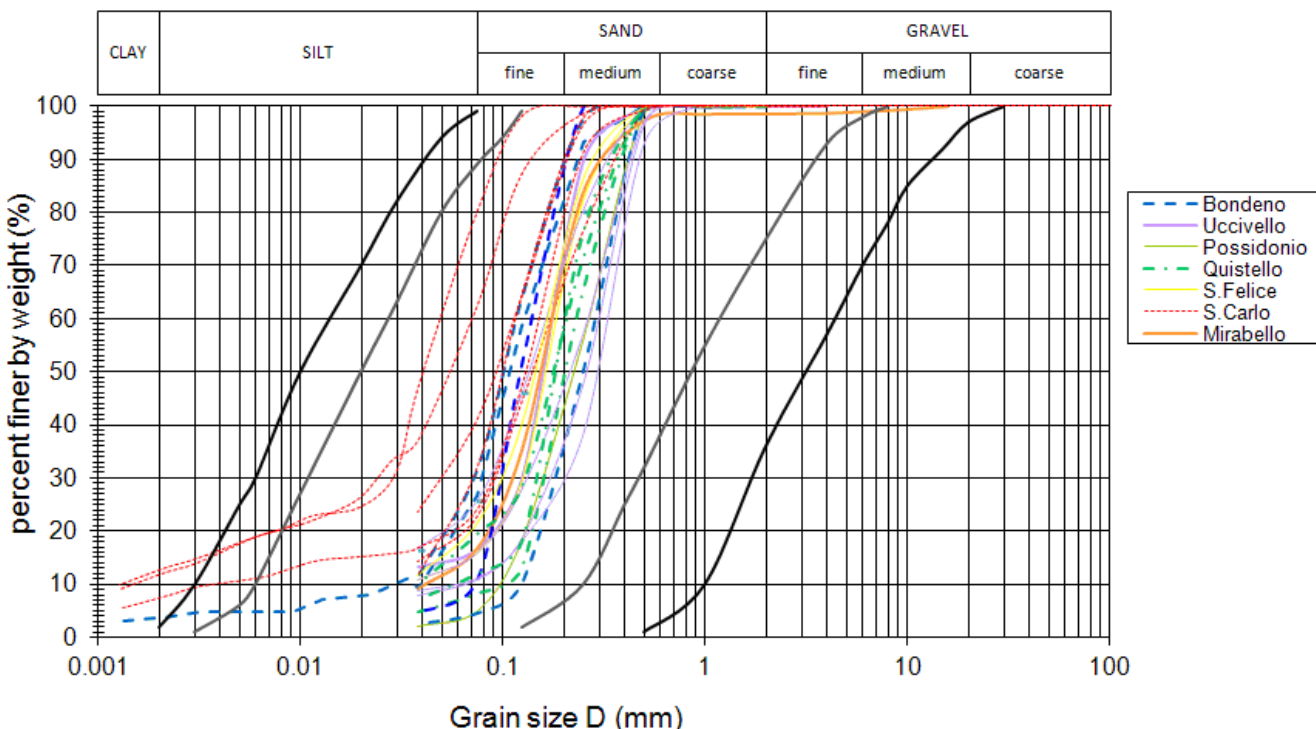
Figure 3. Grain size distribution of liquefied soils. Black lines, boundaries for potentially liquefiable soils [Obermeier 1996]; gray lines, interval with high potentially liquefiable soils (uniformity coefficient